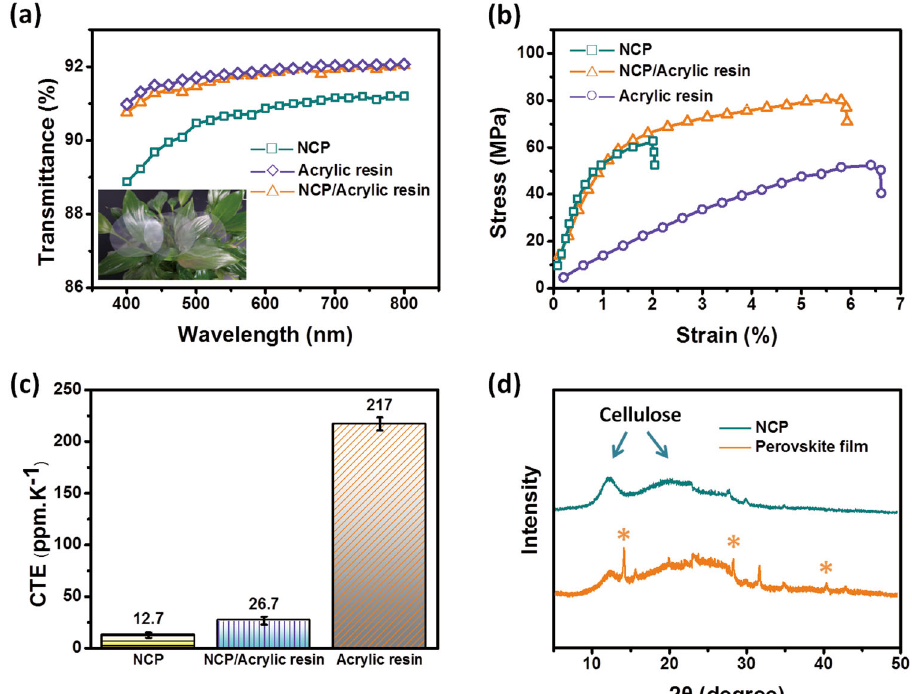
Fig. 3 Comparison of NCP and NCP-based substrate with coating of acrylic resin. a Transmittance, b strain – stress curve, and c coef fi cient of thermal expansion (CTE) of NCP, NCP-based substrate and acrylic resin fi lm. Each data point is the mean of three analyses. Inset: digital photograph of NCP, NCP-based substrate and acrylic resin fi lm from left to right. d X-Ray diffraction of NCP and fl exible PSCs prepared on the NCP-based